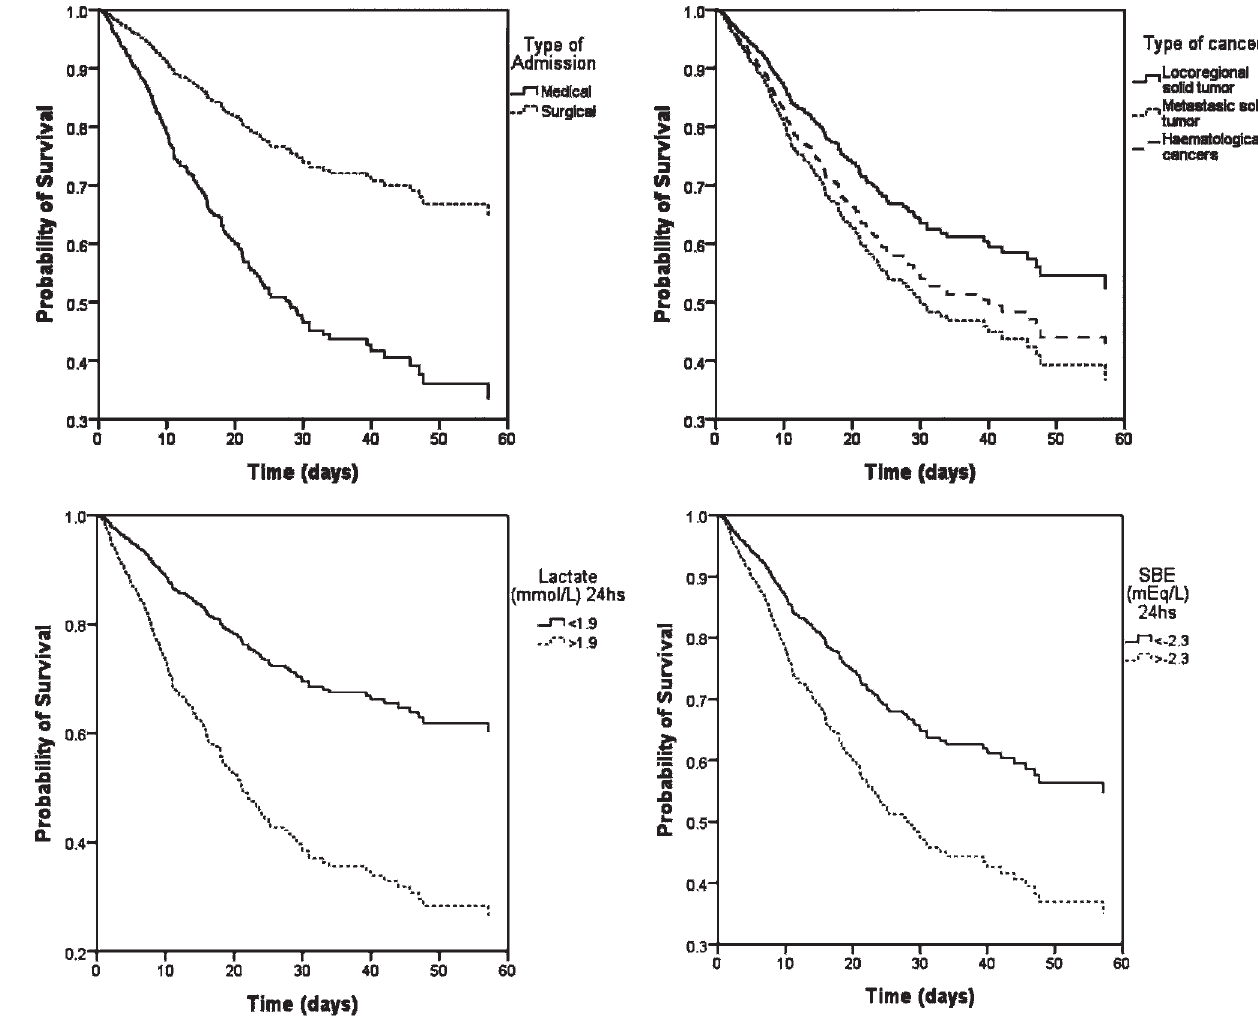
Figure 3 - Survival curves for type of admission, type of cancer and levels of lactate (mmol/L) and SBD (mmol/L) at 24h.